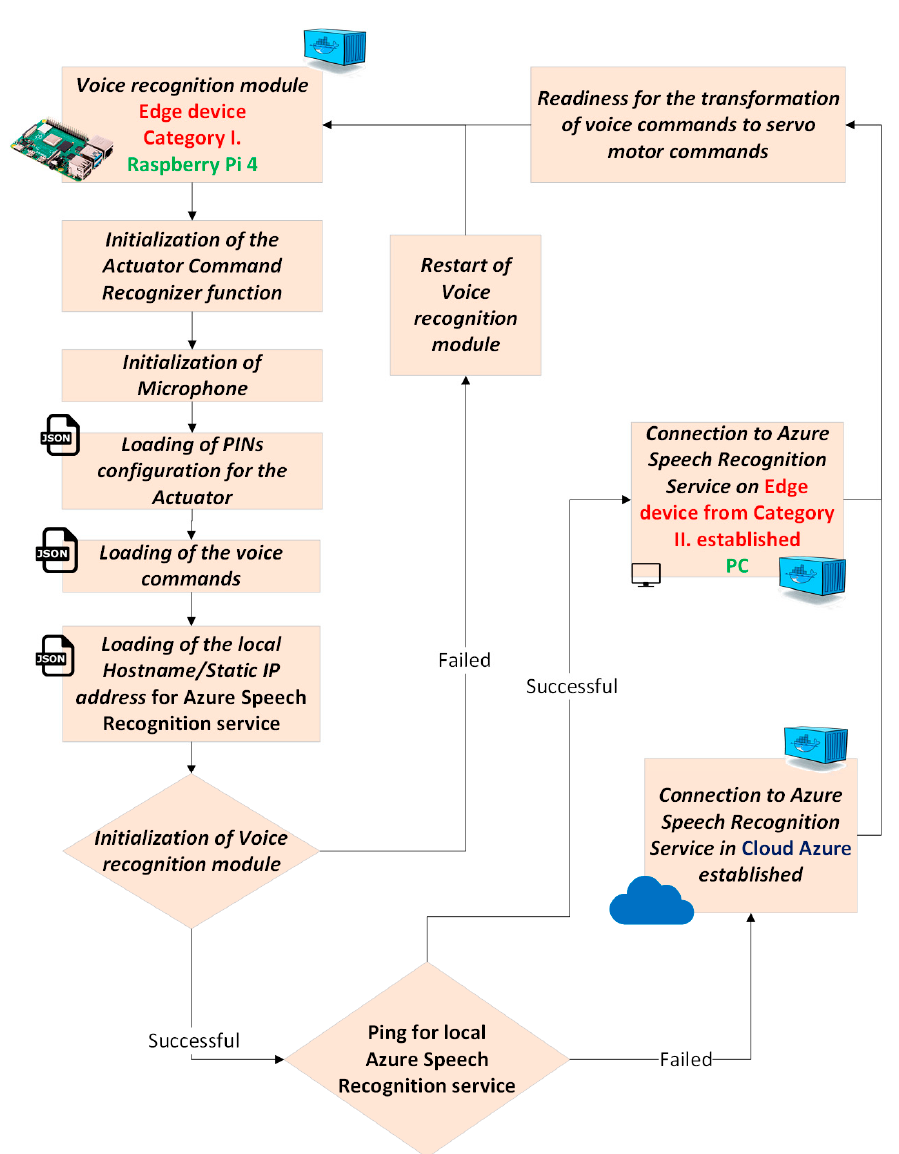
Figure 4. Sequential steps in the proposed architecture of voice